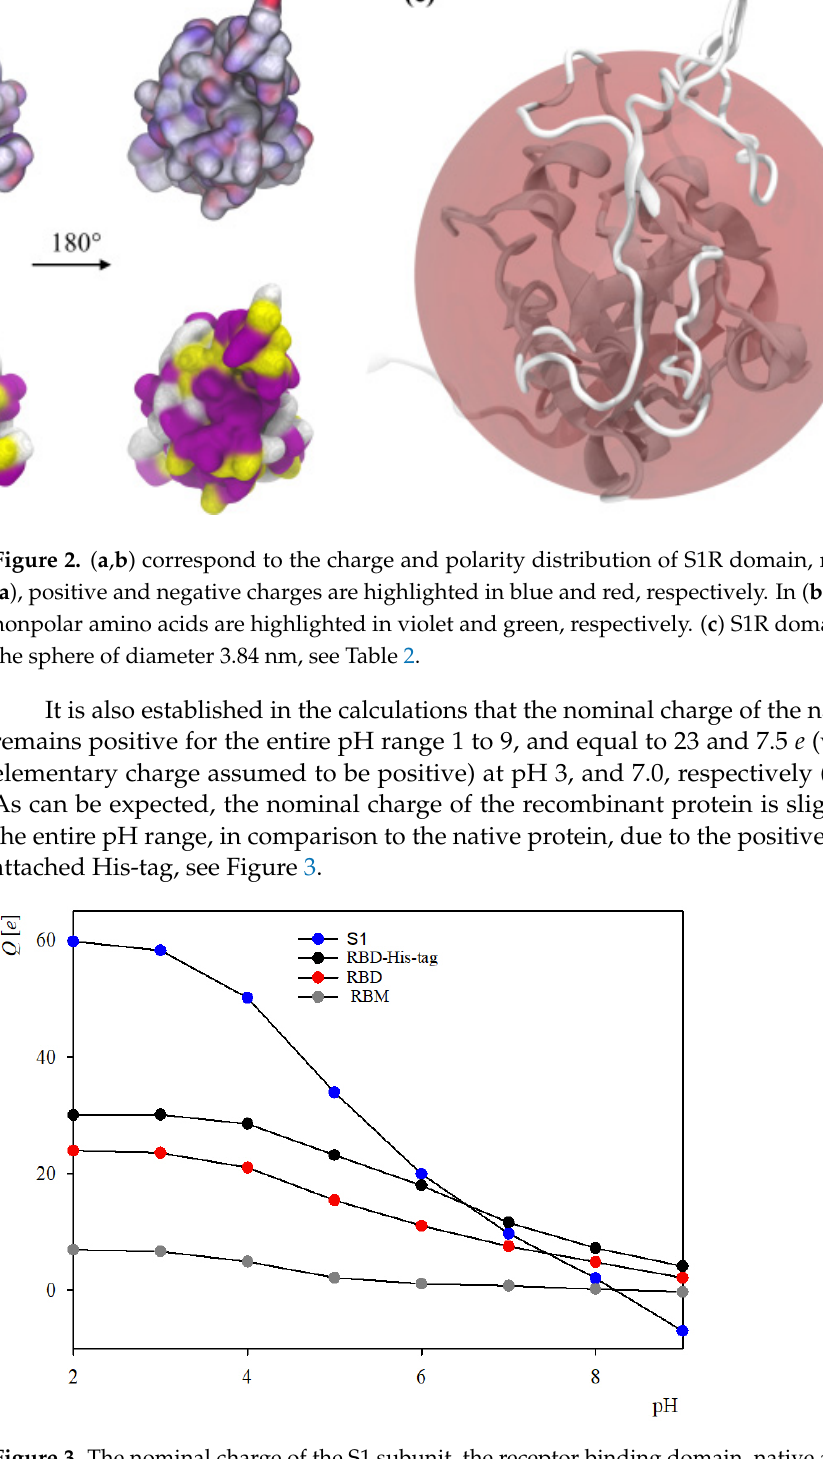
Figure 3. The nominal charge of the S1 subunit, the receptor binding domain, native and His-tagged, and the receptor binding motif (RBM) of SARS-CoV-2 S protein versus pH, determined using the PROPKA algorithm.